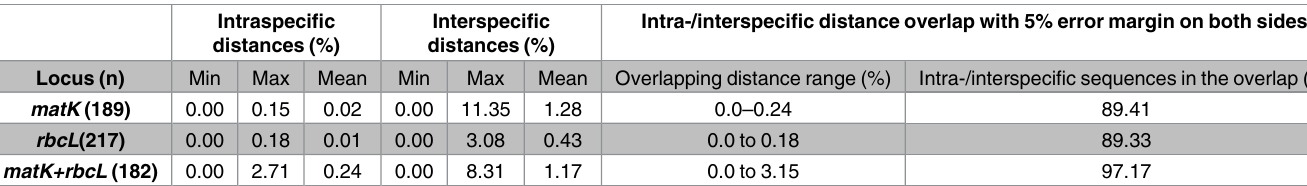
Table 2. Pairwise intraspecific and interspecific distances in the barcode loci of all 161 plant species. Intraspecific Interspecific Intra-/interspecific distance overlap with 5% error margin on both sides distances (%) distances (%)